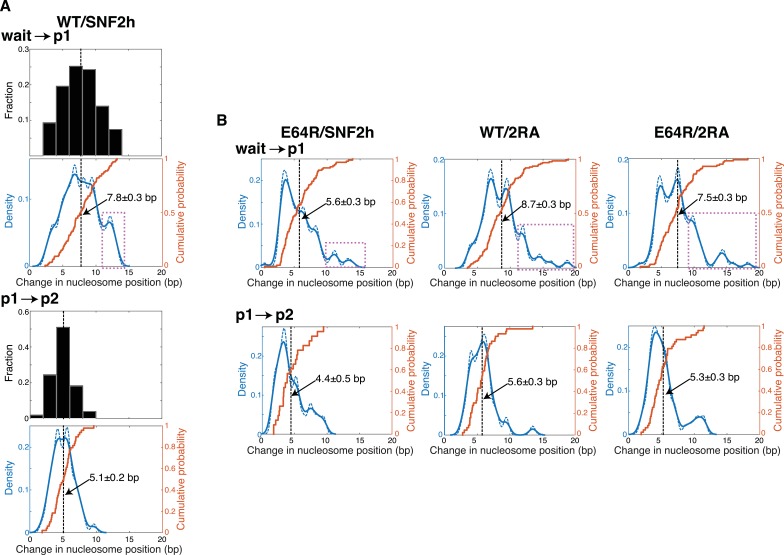
The step size of WT SNF2h with WT nucleosomes is comparable to step sizes previously described for ISWI family remodelers.(A) Three different representations of the change in nucleosome position (that is, the step size) during the first (top) or second (bottom) translocation event observed by smFRET, for the ≥100 remodeling trajectories collected with WT nucleosomes and WT SNF2h. The three representations are: histograms in black; kernel density estimations (KDEs) with two different bandwidths (0.6, solid blue lines; 0.4, dashed blue lines) in blue; and cumulative distribution functions (cdfs) in orange. Vertical black dashed lines indicate the mean value, with the value of this mean step size ± SEM given on the KDE/cdf plot. The histograms in black illustrate how the step sizes for SNF2h generally form a cluster, consistent with previous reports for other ISWI-family remodelers (Blosser et al., 2009; Deindl et al., 2013; Hwang et al., 2014). However, the other two representations of the same data reveal additional structure that is difficult to discern from the histograms alone. For example, the purple box over the top KDE indicates steps that likely represent nucleosomes that skipped the p1 pause, or whose p1 pause was too short to detect, such that the nucleosome was moved ~(eight bp +5 bp)=13 bp during the first translocation. For WT ISWI-family remodelers remodeling WT nucleosomes, the initial step has been reported to range from 6.9 ± 0.1 bp to 7.4 ± 0.1 bp, and the second step from 3.0 ± 0.1 to 3.7 ± 0.2 (Blosser et al., 2009; Deindl et al., 2013; Hwang et al., 2014). The difference of ~1 bp in the size of the second step between our work and that in the literature likely results from the different approaches used to obtain the mean step size. B. KDE and cdf plots as in A, but for the other three combinations of nucleosomes and SNF2h constructs shown in Figure 3. Due to their lack of binning or smoothing parameters, cdfs represent the best quantitative comparison between data sets. However, for assessing the step size within a single data set, KDEs can provide a more intuitive picture. Cdfs here are the same as in Figure 3E (though shown here without the error estimate).